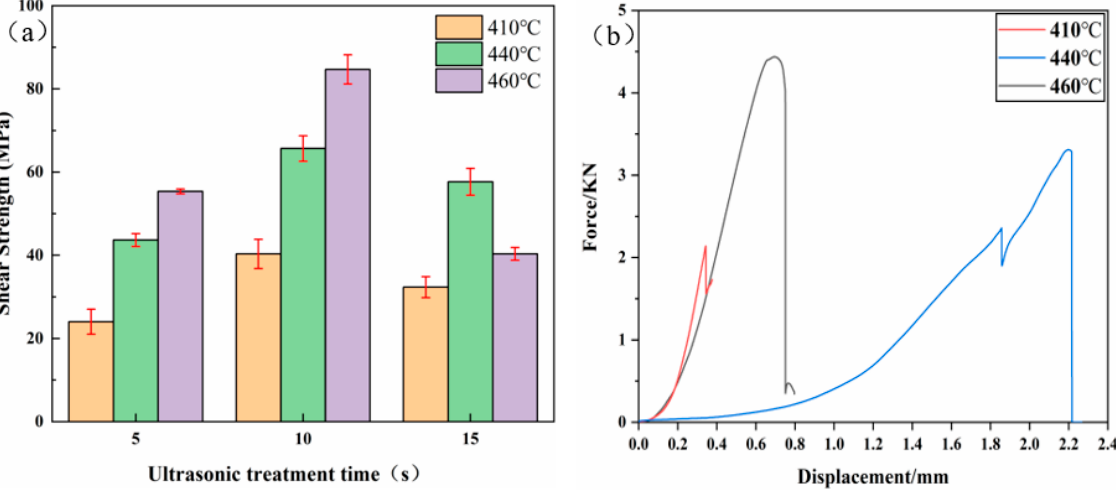
Figure 5. Shear strength of the joints ( a ) and force–displacement curves ( b ) at 410 °C, 440 °C, and 460 °C with increasing UST.